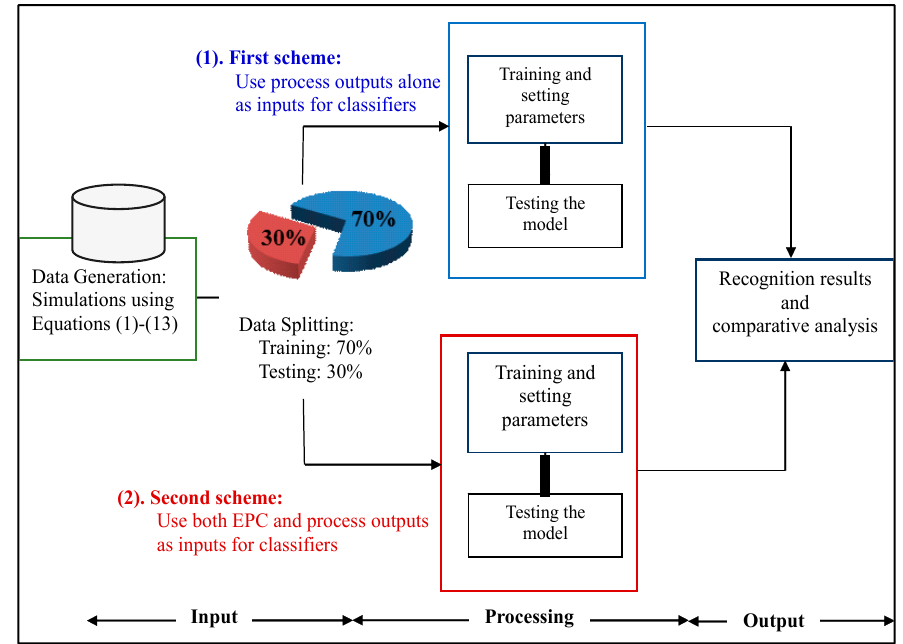
Figure 3. The research framework.